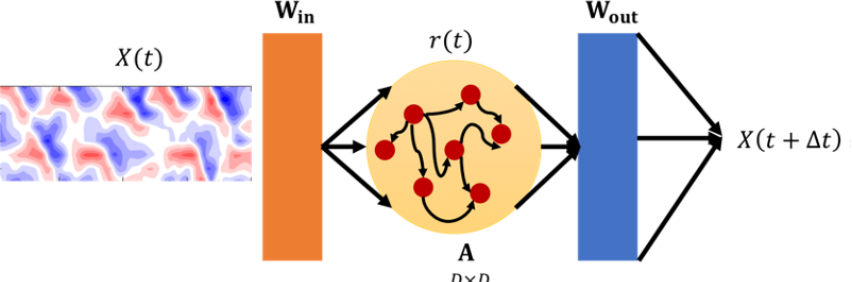
Figure 3. A schematic of RC–ESN. D × D is the size of the adjacency matrix of reservoir A . X(t) ( − T ≤ t ≤ 0) is the input during training. W in and A are random matrices that are chosen at the beginning of training and fixed during training and testing. Only W out is computed during training. During testing ( t > 0), X(t + (cid:49)t) is predicted from a given X(t) that is either known from the initial condition or has been previously